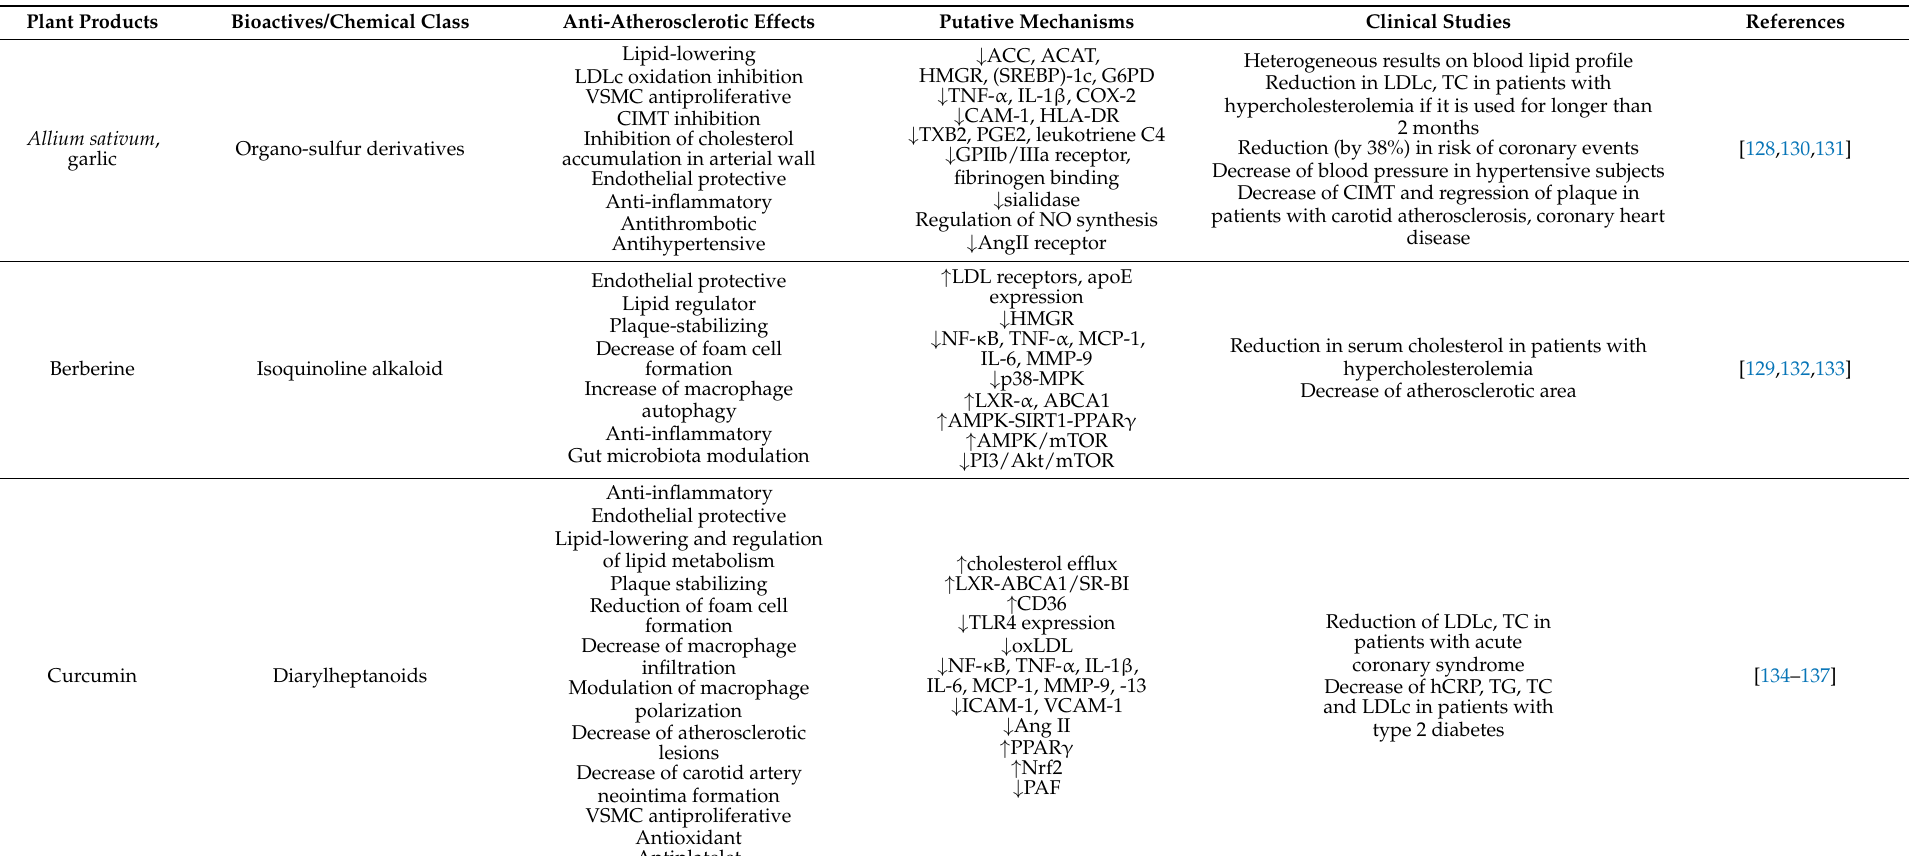
Table 1. Natural products and their anti-atherosclerotic